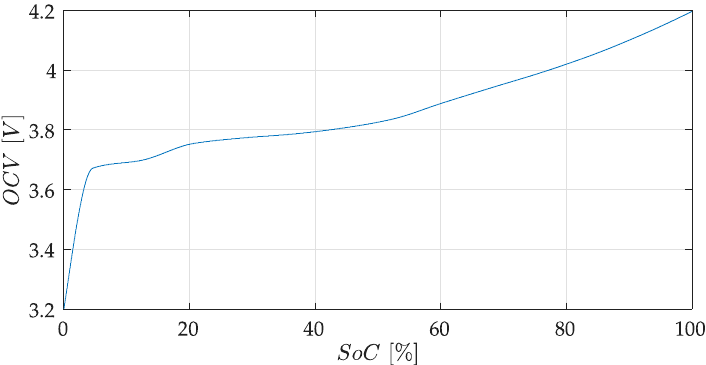
Figure 10. OCV-SoC curve referring to the NASA battery